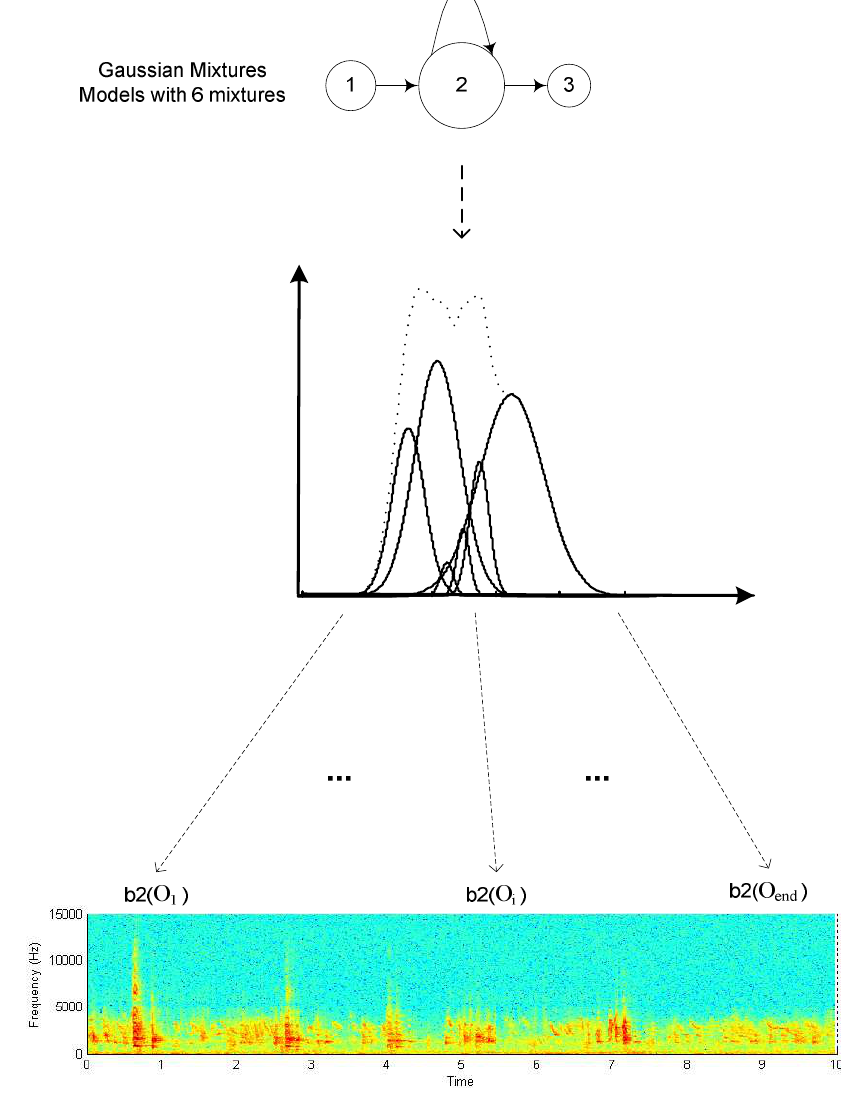
Figure 2. GMM model aligned to a non-stress condition poultry